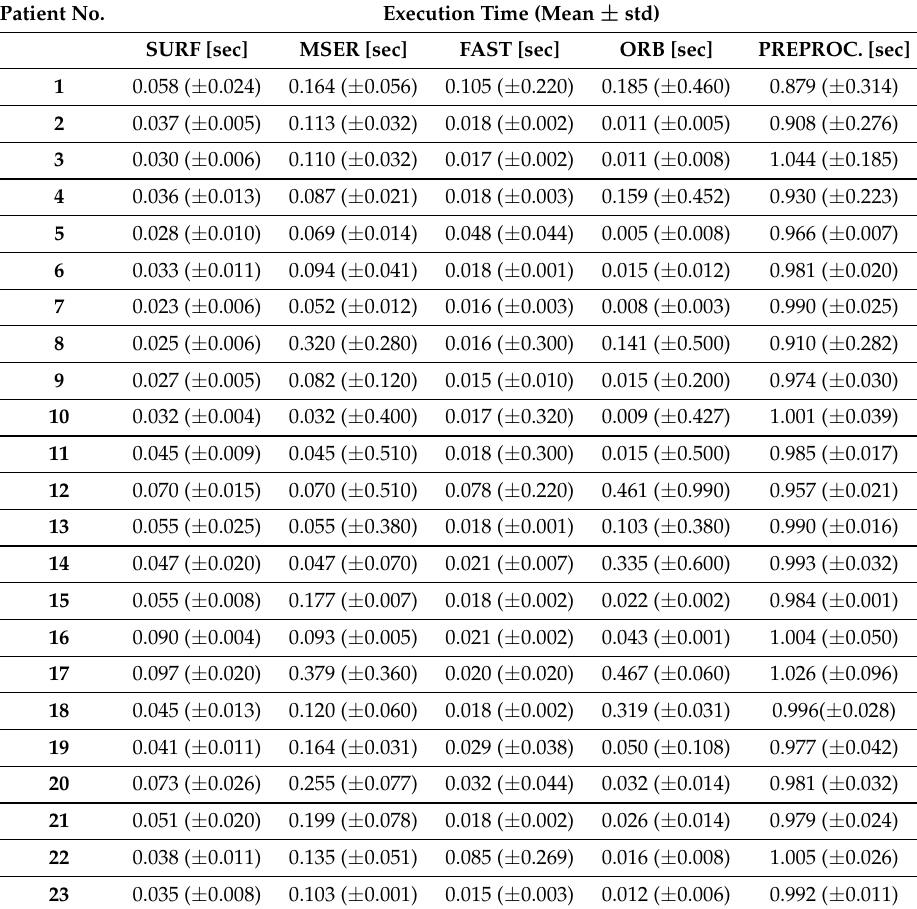
Figure 12. Cumulative distribution function (CDF) of the triangulation error for the four methods. The dotted area delimits the 95% confidence interval for each CDF. The triangulation error of the analyzed frames is lower than 0.5 mm in more than 97% (SURF) or 95% (FAST and ORB). For MSER, however, the corresponding number is 84%, likely explained by the larger variability in triangulation errors. Table 3. Mean and standard deviation of execution time for different feature detection methods, and preprocessing on all patients (pair of frames). Patient